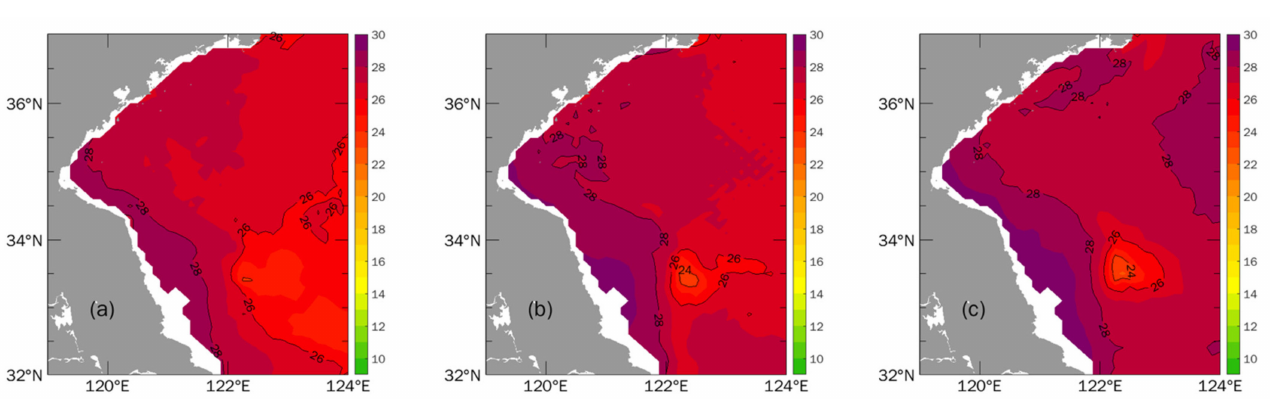
Figure 8. Horizontal distributions of simulated temperature at 5 m depth in Exp.C on ( a ) 26 July, ( b ) 4 August, and ( c ) 11 August 2019 (unit: ◦ C).